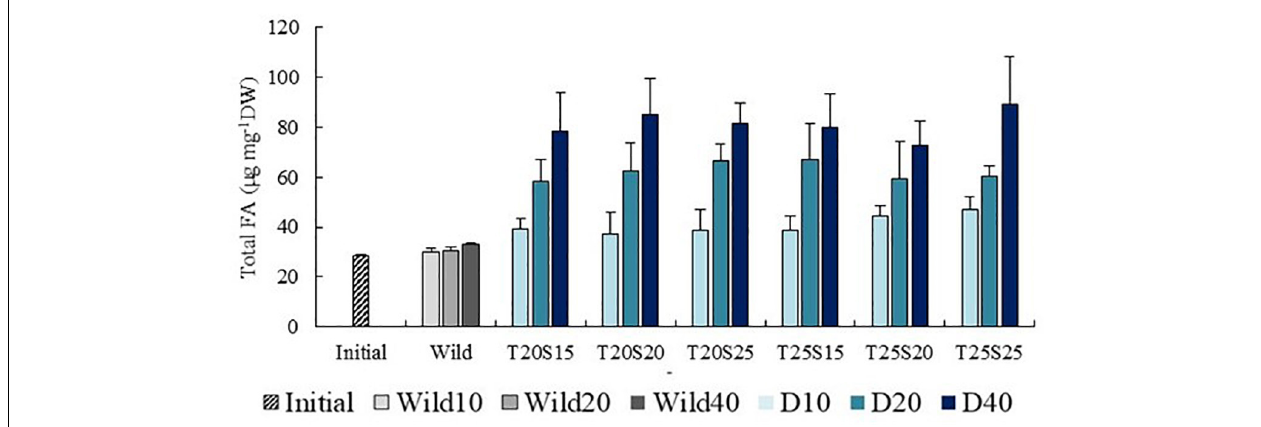
FIGURE 2 | Evolution of the total amount of fatty acids (FA) of Hediste diversicolor fed a commercial aquafeed for 10, 20, and 40 days (D10, D20, and D40) under different combinations of water temperature (T—20 and 25 ◦ C) and salinity (S—15, 20, and 25) contrasted with that of initially stocked conspecifics (Initial) and conspecifics collected from the wild at the same time points (Wild10, Wild20, and Wild40). Average values ( ± SD) ( n = 5).